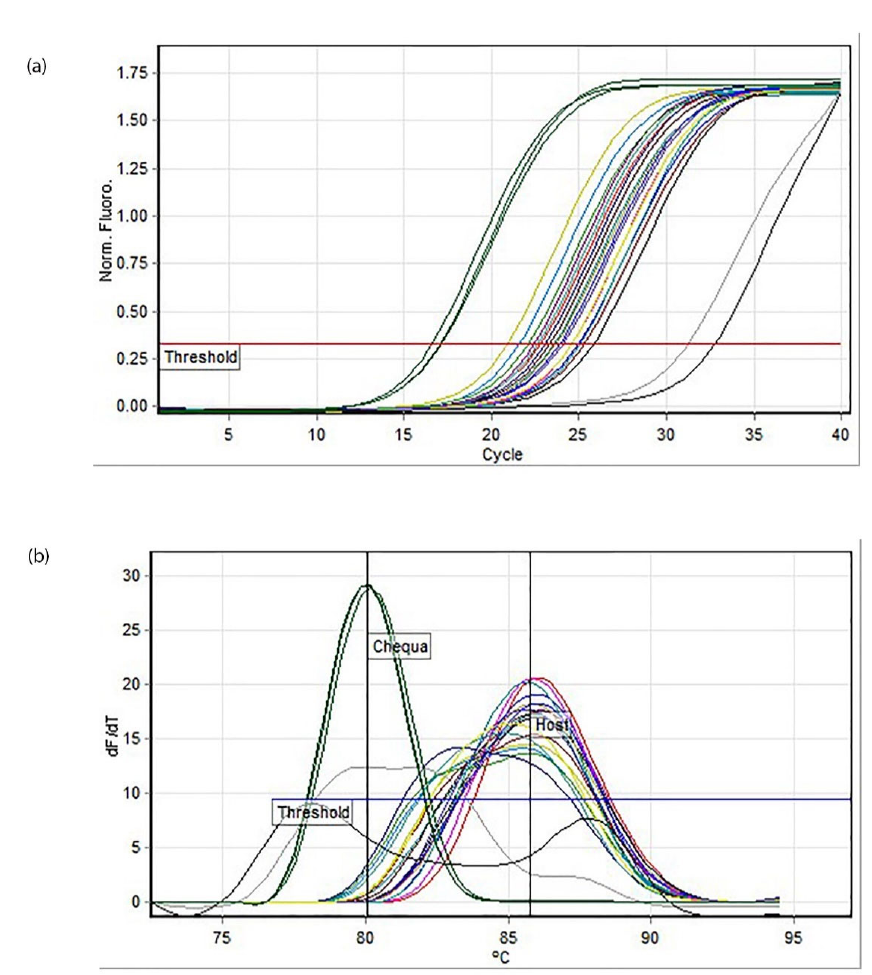
Figure 3. RT ‐ qPCR assay for Chequa iflavirus in all crayfish samples post ‐ injections in Experiment 2: ( a ) amplification plot, ( b ) melt analysis (Mean 85.77, SD 0.31). Green represents Chequa iflavirus standards (10 7 ), and other colours represent the crayfish samples.